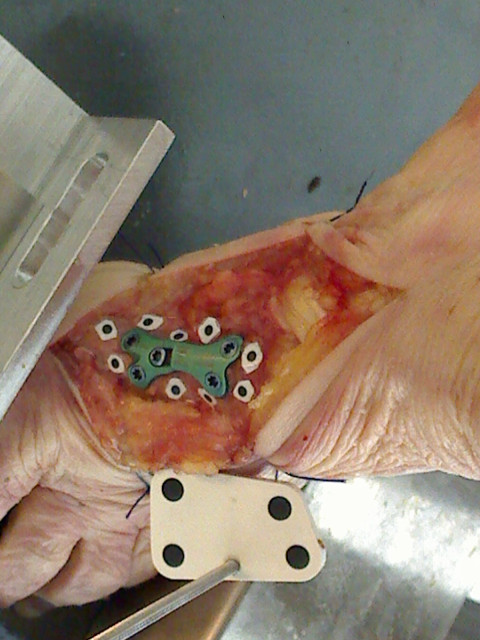
Marker test on the cadaveric foot specimen. The single right camera picture. The nine markers were attached on the first metatarsal bone fragments fixing with a locking screw plate after a proximal osteotomy. The fiducial marker was placed in the middle of the lower image part.